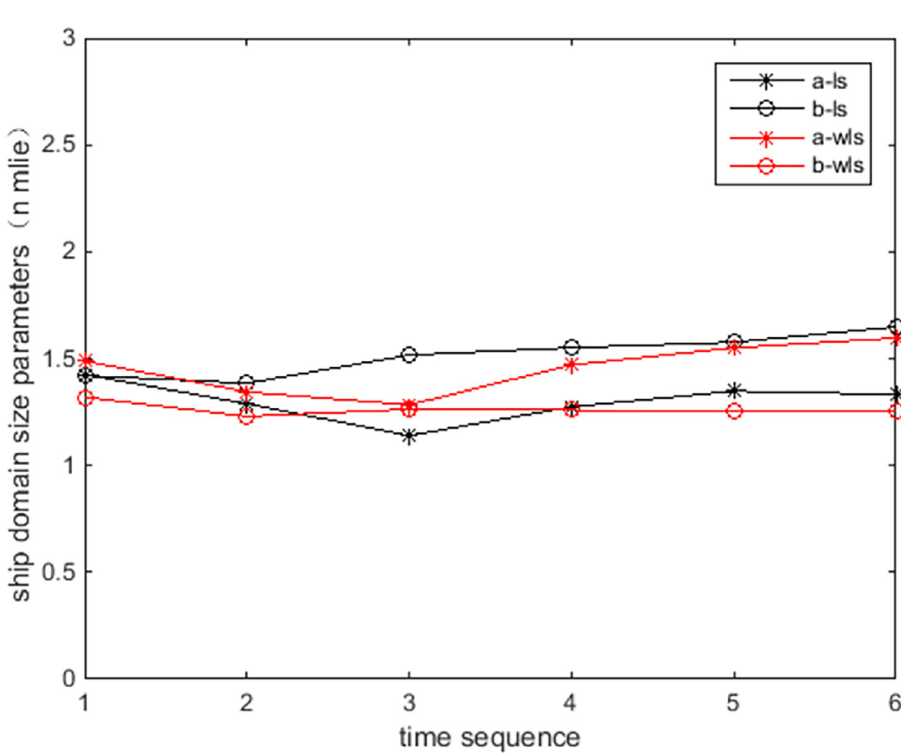
Fig 11. Long and short axes of ship domains by identification.